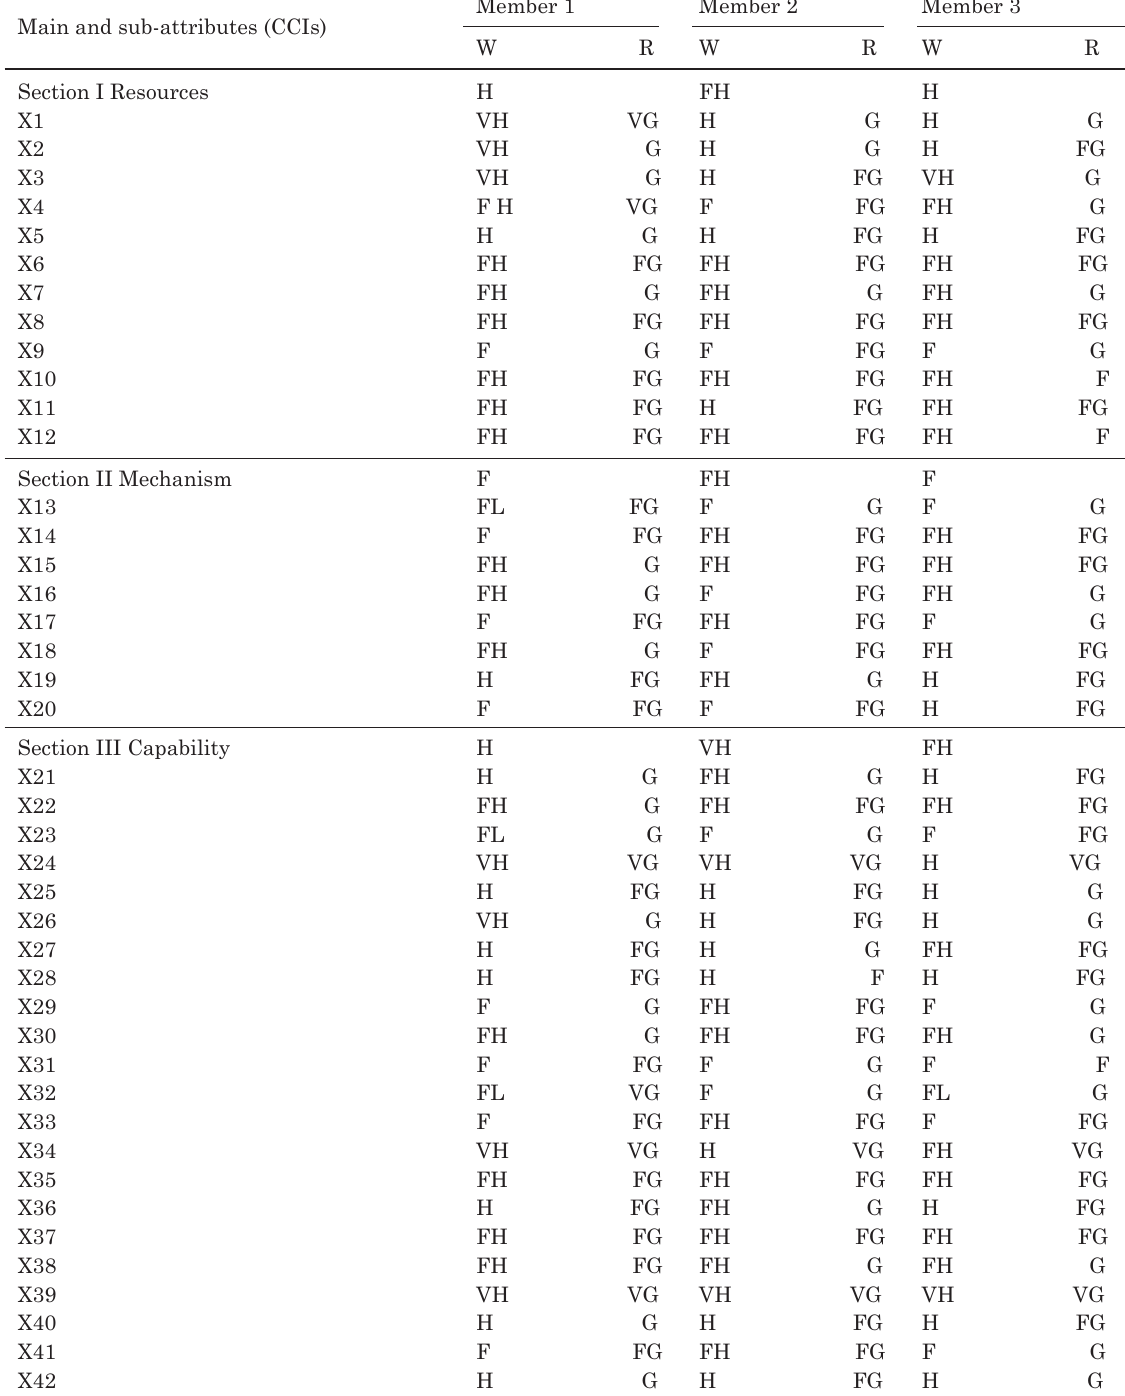
table 5. Panel members’ judgments on the weightings vector (W) and decision ratings (r)